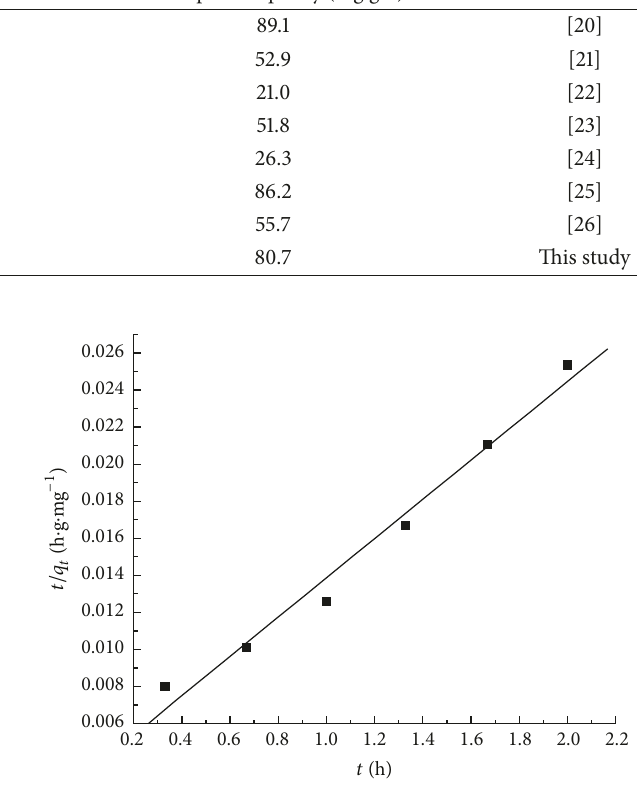
Figure 10: The pseudo-second-order kinetic model of Cr(VI) ad- sorption using hybrid membrane of carboxymethyl chitosan and silicon